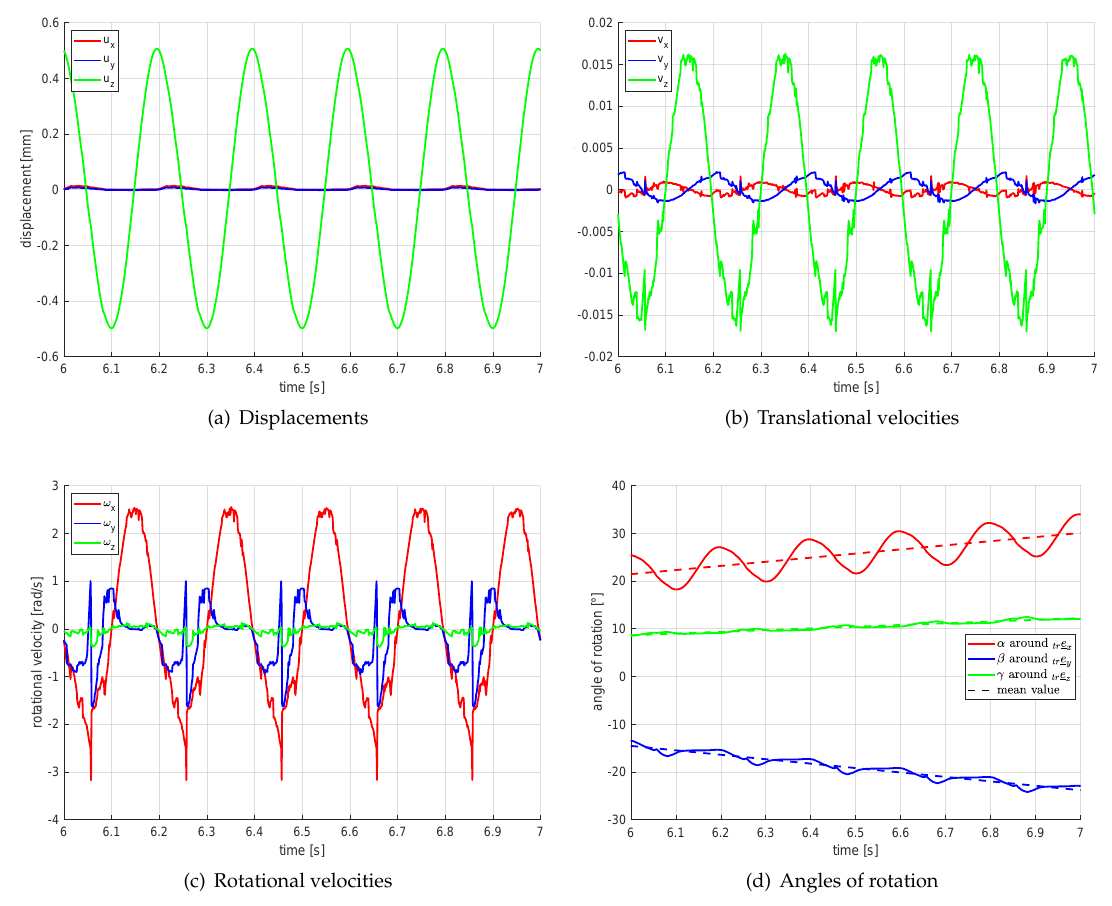
Figure 13. Kinematic pathways of the ball in the track of the inner race.